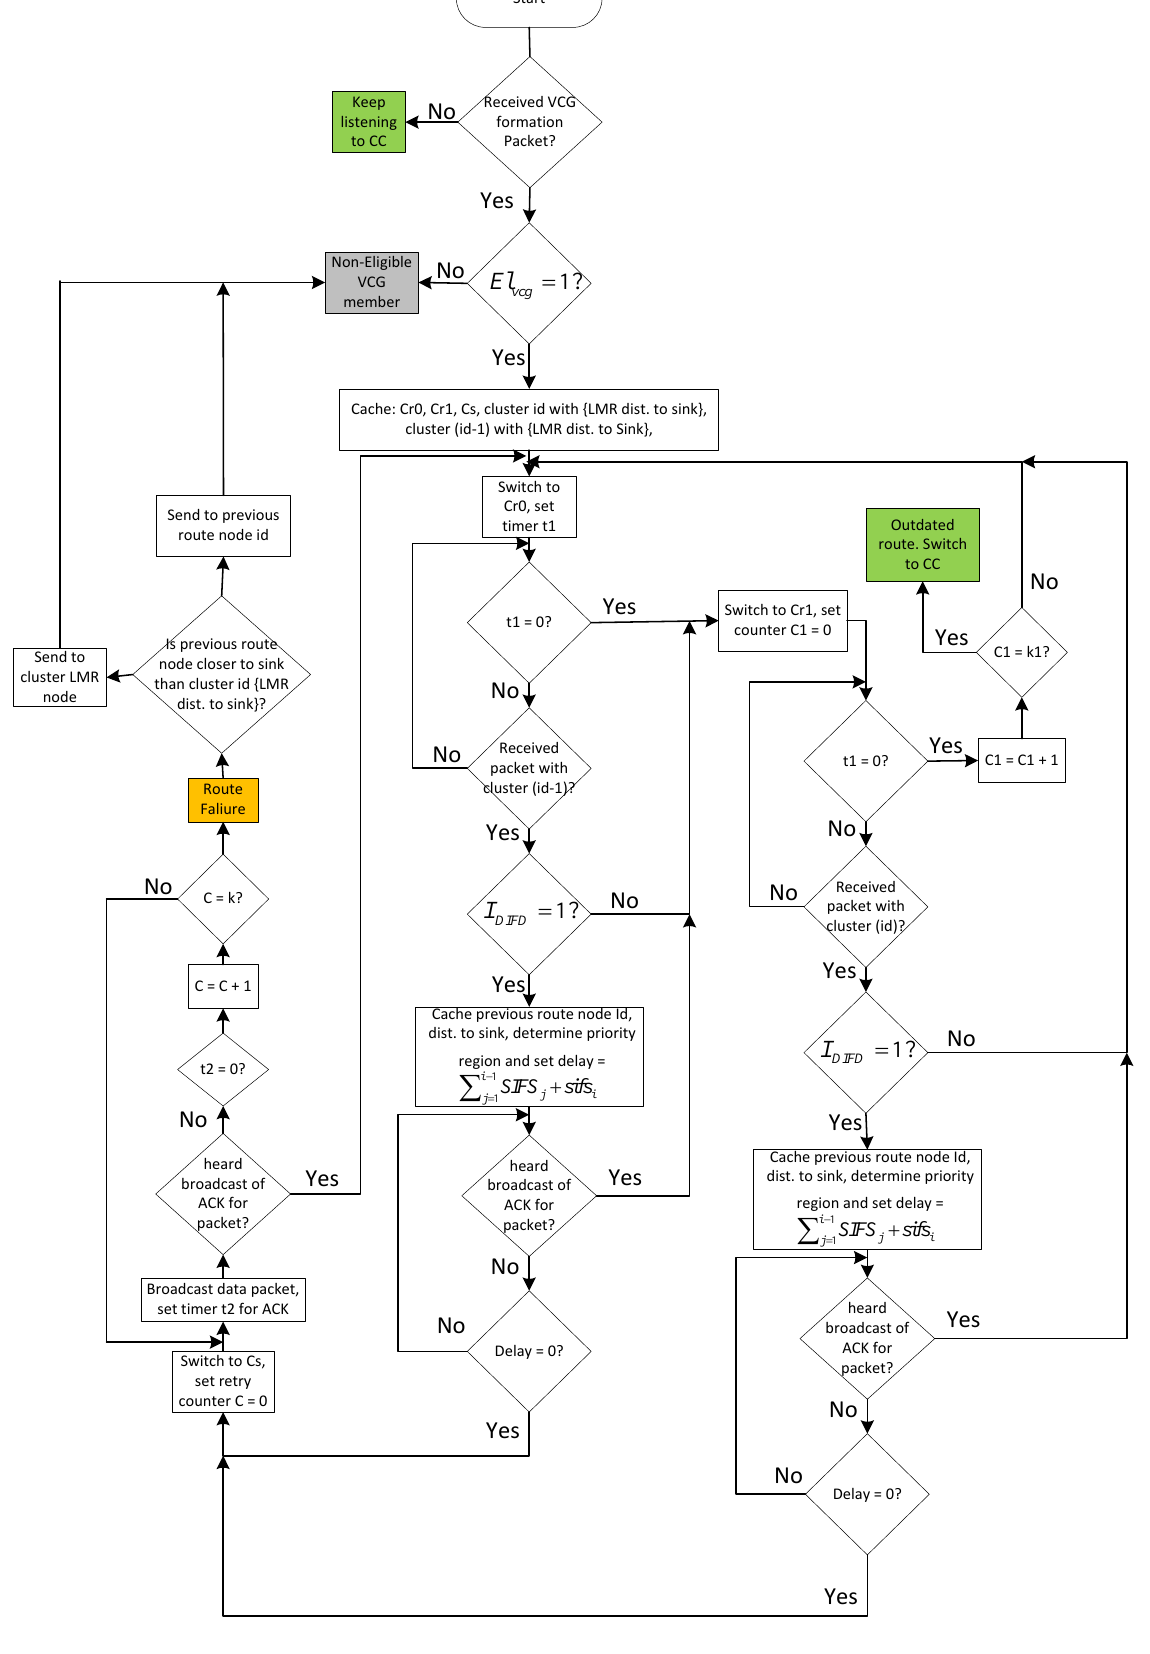
Figure 8. Flow chart for ROR node forwarding algorithm. CC, control channel; SIFS, short inter-frame space; DIFD, data initiative forwarding